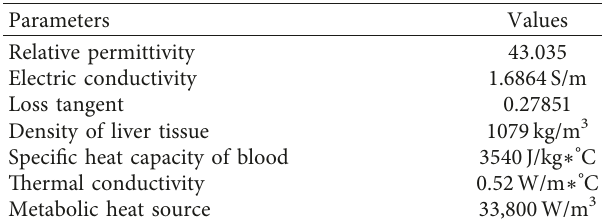
Table 1: Properties of liver